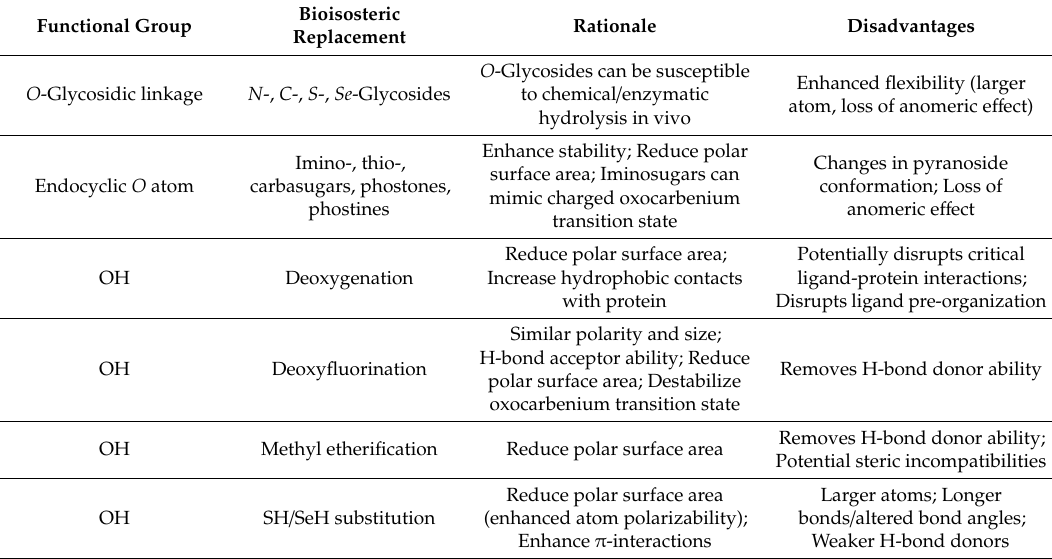
Table 1. A summary of the di ff erent bioisosteres of carbohydrate functional groups discussed in this review, including the rationale behind the selected